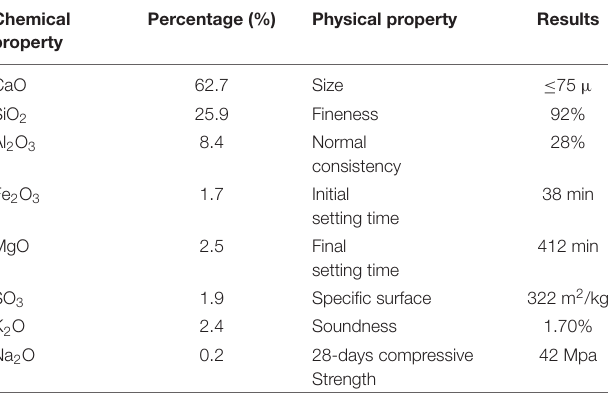
TABLE 1 | Physical and chemical property of OPC.